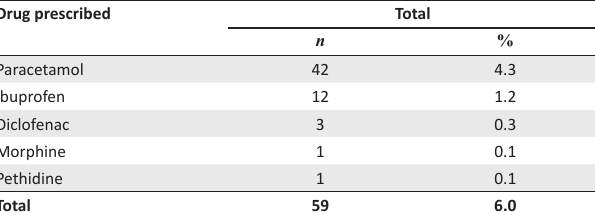
TABLE 1: Patient diagnoses, triage score and age distribution. Patient